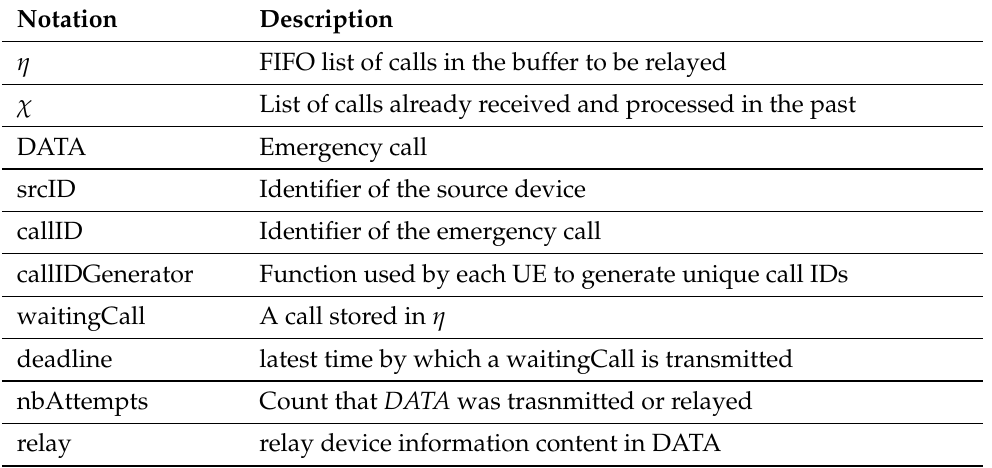
Table 2. Notations used in Algorithms